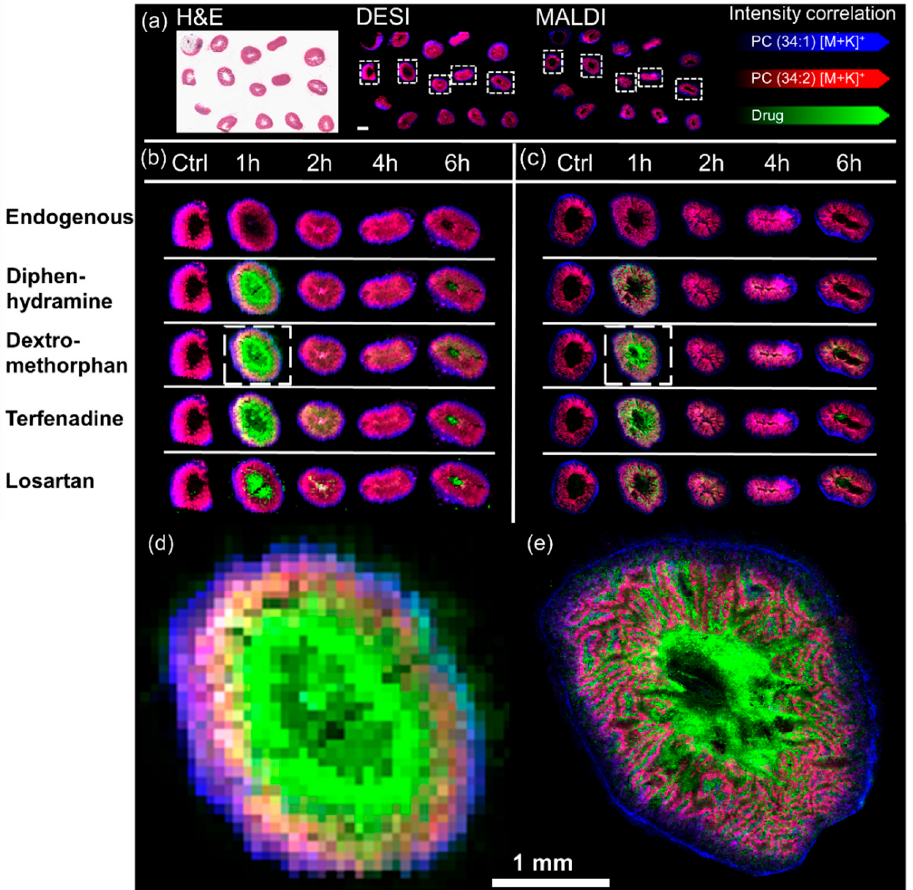
Figure 2. Representative spatial distribution of the cassette dosed drugs determined by DESI-MSI and MALDI-MSI: ( a ) Panorama view on a whole post-DESI H&E stained slide (left) as it was analyzed in one experiment by DESI-MSI (middle) and MALDI-MSI (right). The scale bar in the DESI insert is 2 mm wide. The spatial distribution of all four dosed drugs is shown in one representative replicate for all timepoints in relation to endogenous species outlining the tissues. The left-hand side of the figure shows the results of ( b ) DESI-MSI experiments performed with a spatial resolution of 75 µm whilst the right-hand side of the figure shows the results of ( c ) MADI-MSI experiments acquired with a spatial resolution of 10 µm. The inserts ( d , e ) display the spatial distribution of dextromethorphan in the highlighted tissue sections in ( b , c ) respectively.